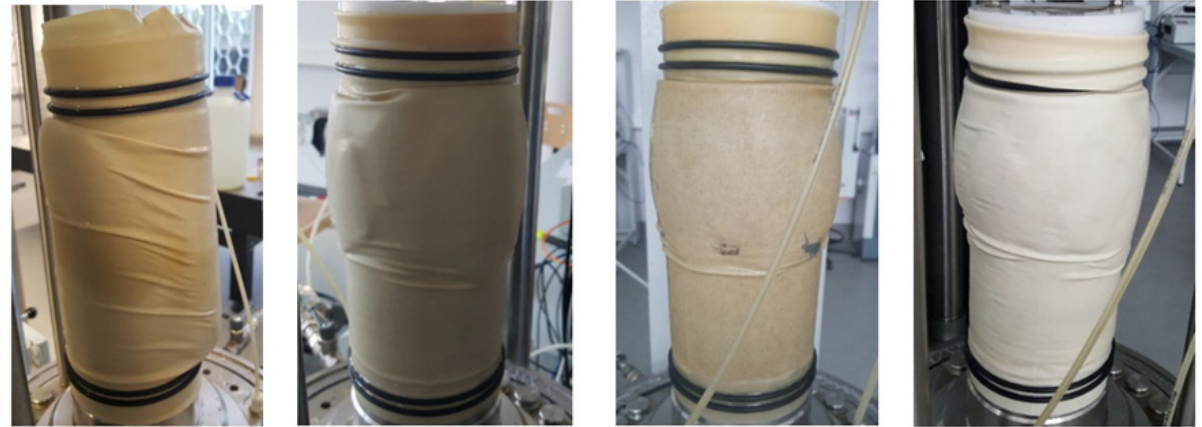
Figure 3: Sample failure shape (from left to right): unreinforced; reinforced with Basetrac ® Grid PP 40 geogrid; reinforced with Basetrac ® Grid PET 40 geogrid; reinforced with Secugrid 40/40 Q1 geogrid.